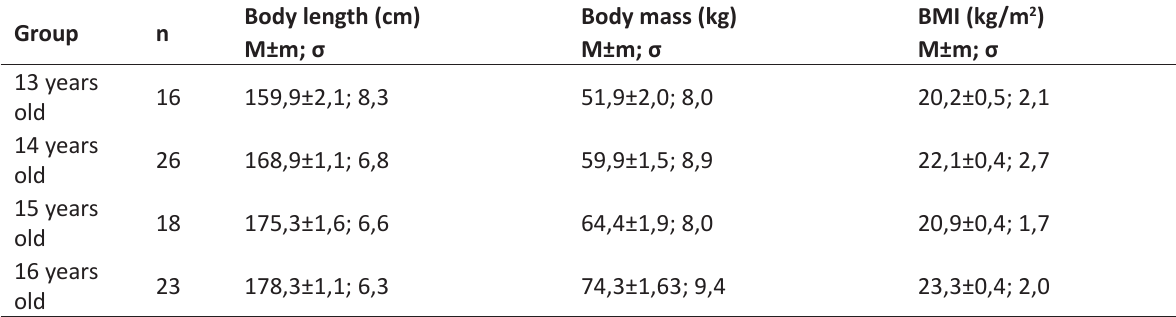
Table 1. Anthropometric indicators of hockey players from 13 years to 16 years